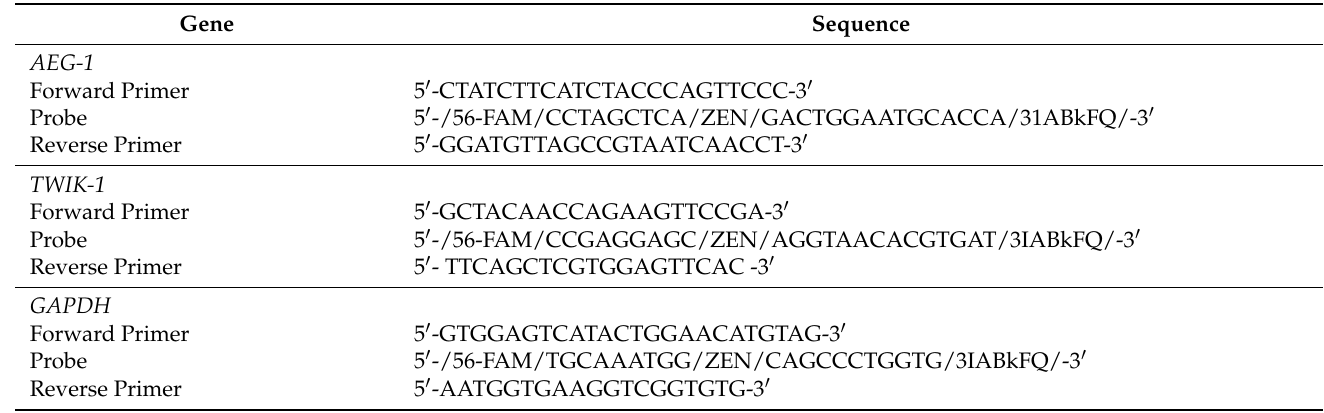
Table 1. qRT-PCR Primers and